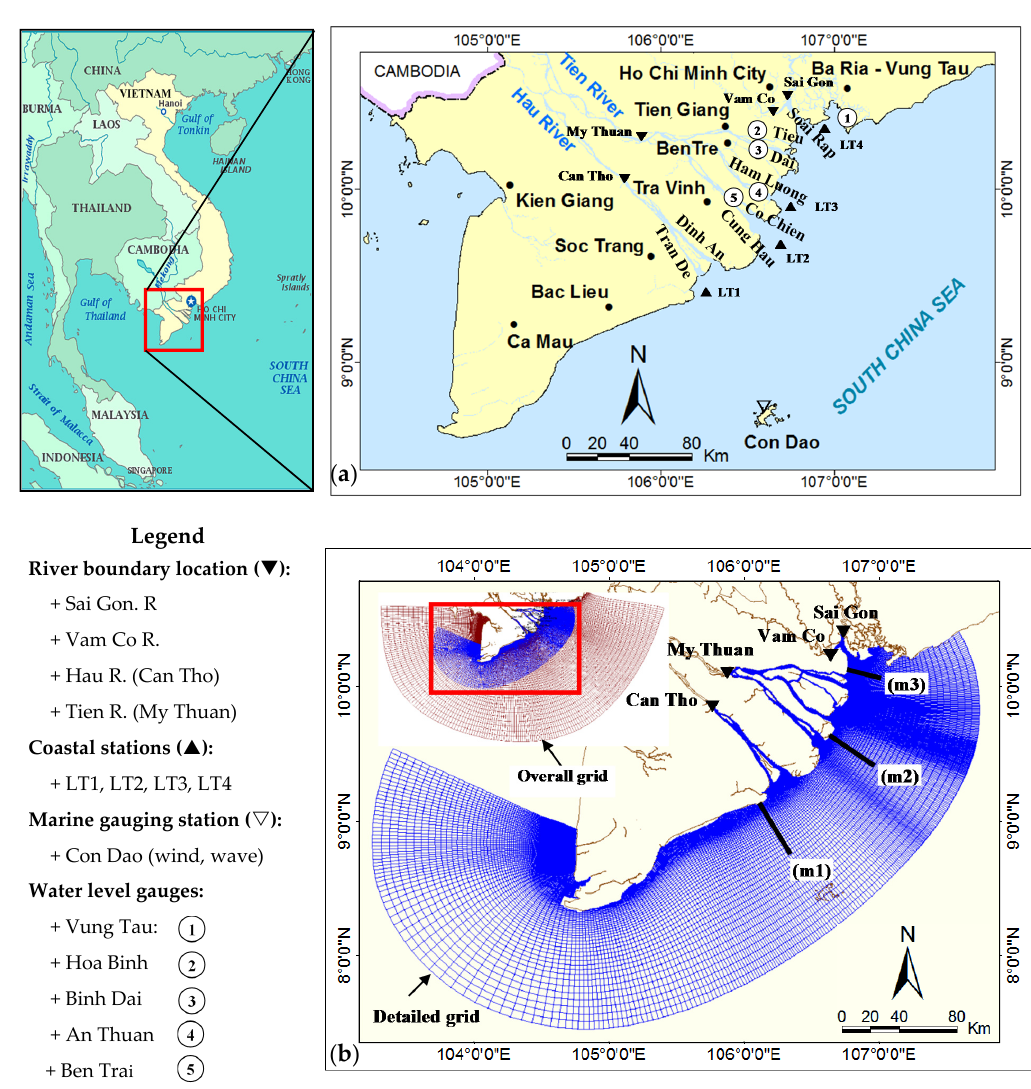
Figure 1. The Mekong River Delta and its region of freshwater influence. ( a ) General map with locations of measurements (coastal stations LT1, LT2, LT3 and LT4; marine gauging station of Con Dao; water level gauges); ( b ) The parent grid outside and the child grid over the study area, with locations of the river boundaries of the model, and cross sections (m1, m2 and m3) used in the calculations. During the last 4500 years, the MRD prograded more than 250 km to the southeast [18]. Approximately 3000 years ago, the prodelta was located near Ben Tre and Tra Vinh cities (see